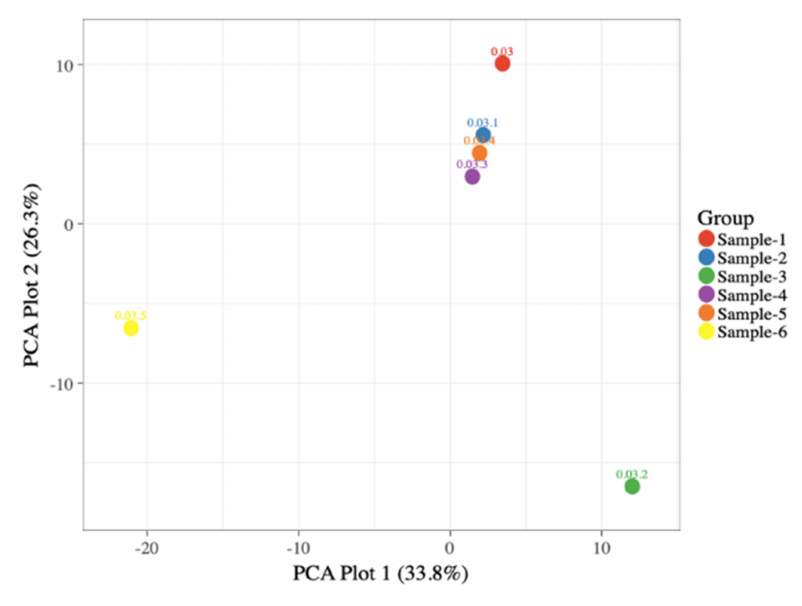
Figure 4. Principal component analysis (PCA). PCA plot illustrating correlation among six samples (five soil samples and one water soil sample) from arid and semi-arid regions of